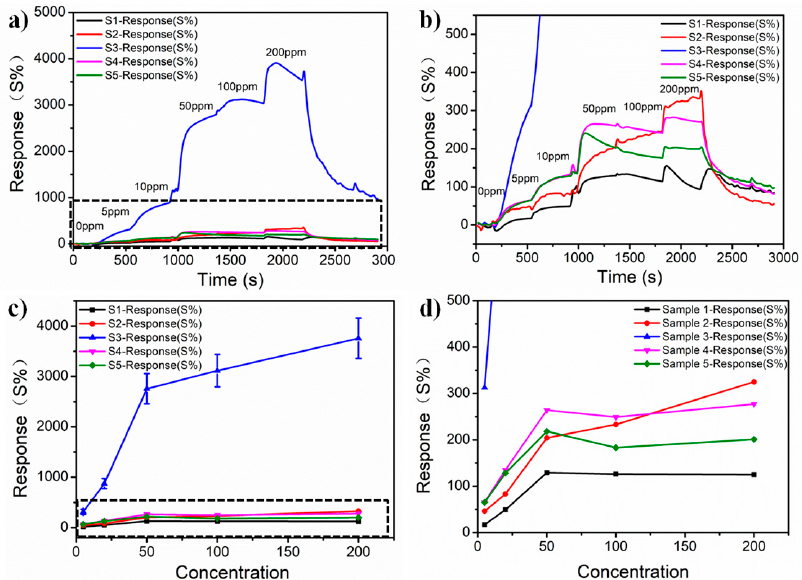
Figure 4. Response of ammonia gas sensors using different samples. ( a ) Response-recovery curves of the sensors up to 0–200 ppm NH 3 ; ( b ) Magnification of the black dashed pane in ( a ); ( c ) Response towards five (5–200 ppm) different concentrations of NH 3 in air; ( d ) Magnification of the black dashed pane in (c).